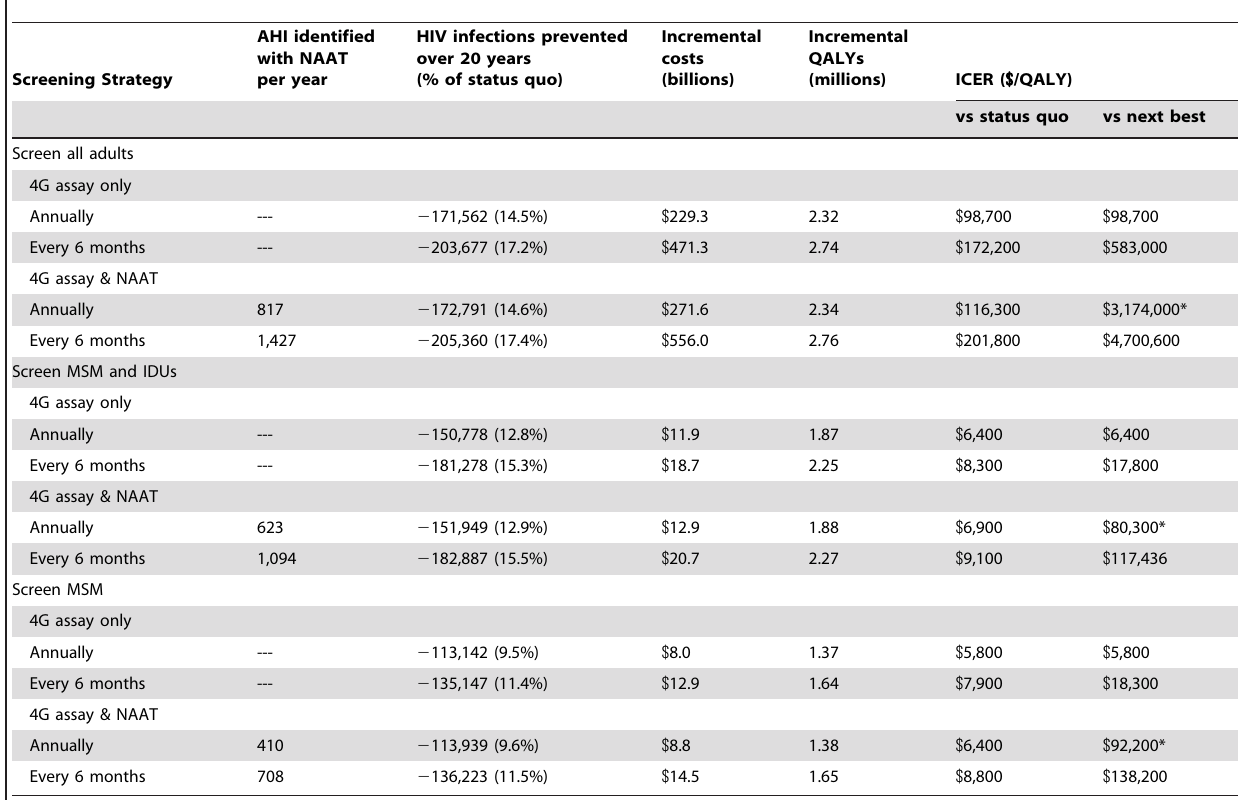
Table 2. Health and economic outcomes over 20 years with 4th-generation immunoassay.